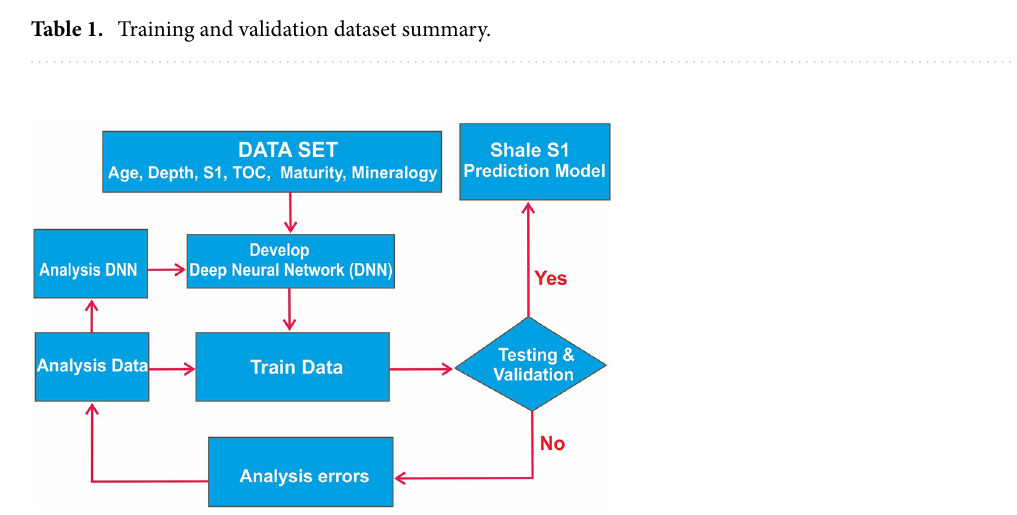
Figure 2. A proposed workflow showing the steps followed in this study to predict the S1 volumes of